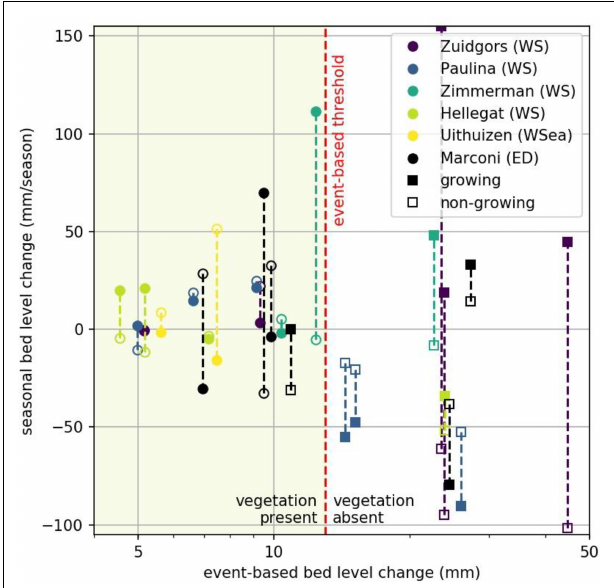
FIGURE 11 | Short-term event-based bed level change represented by the standard deviation ( x -axis; log-scale) and medium-term seasonal rates of bed level change ( y -axis) for all measurement stations. The maximum event-based threshold delimits the bed-level dynamics for which vegetation is present (left of graph). Circles: vegetated, squares: non-vegetated, filled: growing season, open: non-growing